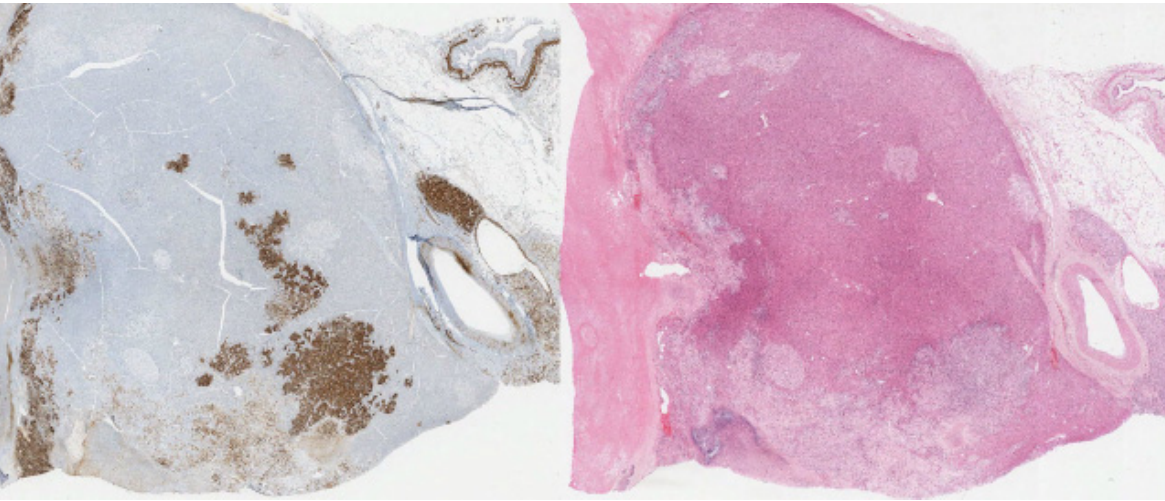
Figure 9. (10x): Desmin stain: strongly positive in the sarcoma component of the tumor with IHC for comparison.